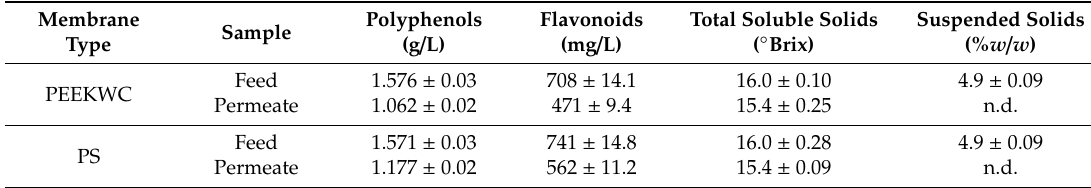
Table 3. Physico-chemical characteristics of fresh and clarified pomegranate juice with PEEK-WC and PS